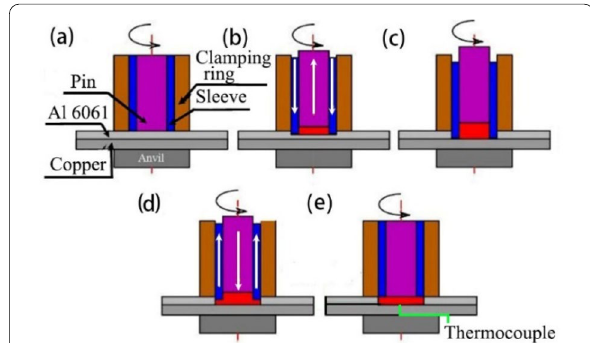
Figure 1 Refill FSSW process: ( a ) preheating before penetration, ( b ) sleeve penetration, ( c ) stirring after penetration, ( d ) sleeve retraction, and ( e ) flatten weld surface after retraction